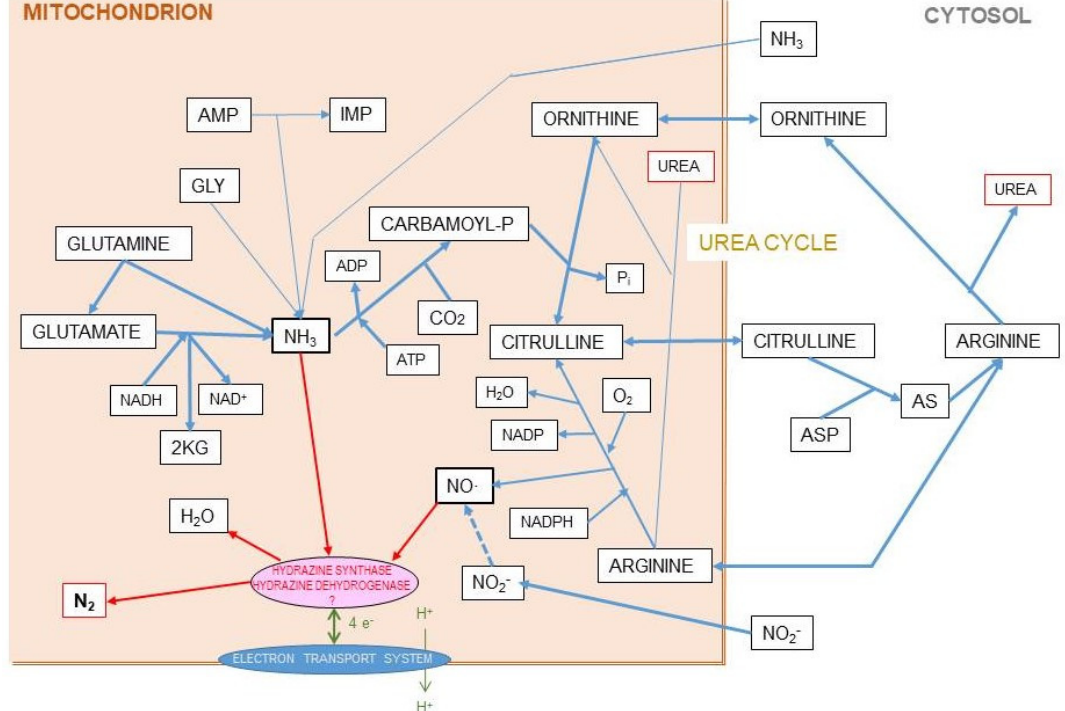
Figure 8. Hypothesis for the origin of ammonia and nitric-oxide generation of nitrogen gas in mitochondria. The coexistence in the liver mitochondrial matrix of both ammonia/ammonium and nitric oxide, within well-regulated pathways, in significant amounts, and related to the urea cycle, suggests the possibility of a reaction which may generate nitrogen gas at the expense of both. This is a speculative hypothesis, which has not been proven so far. In any case it is di ffi cult to justify the presence of both reactants in a relatively high concentration without interacting, since the uncontrolled chemical reaction between them is spontaneous and exergonic. In this hypothesis, we include the findings of Kartal et al. [137] in their study of the mechanism of ammonia oxidation in anammox bacteria, which has an intermediate metabolite between them, hydrazine (N 2 H 4 ). The two enzyme activities of the complex hydrazine synthase and hydrazine dehydrogenase are intimately related to membrane of the anammoxosome